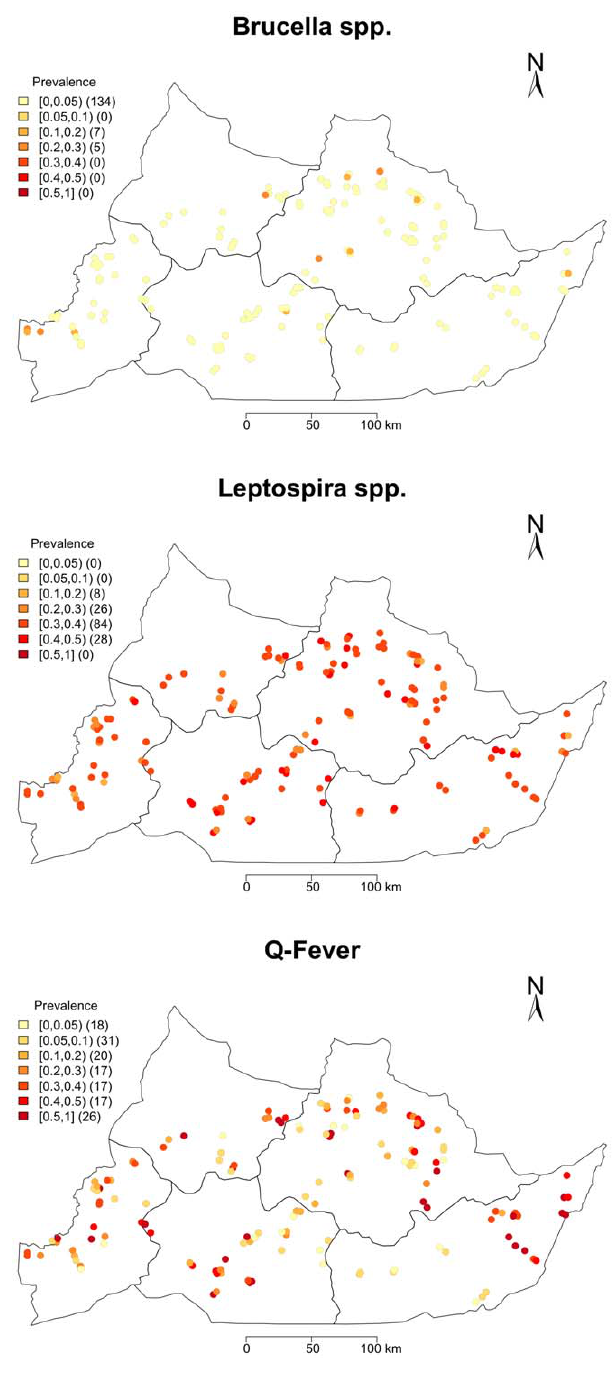
Figure 6. Spatial distribution of sampled herds in the Adamawa Region of Cameroon showing estimated within herd seroprevalence for brucellosis, leptospirosis and Q fever.